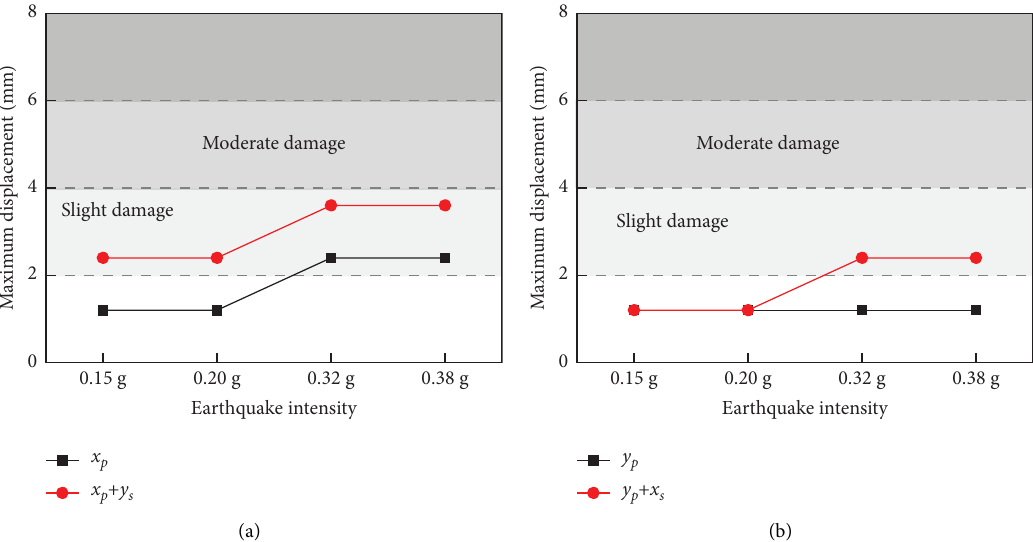
Figure 13: Te maximum displacement and damage level of a fxed spherical bearing (6 #) under diferent earthquake intensities, for (a) x direction and (b) y direction.